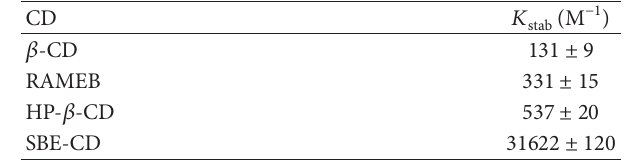
Table 2: Determined 𝐾 stab values at pH 2 for different LAP-CD complexes with UV spectroscopy.